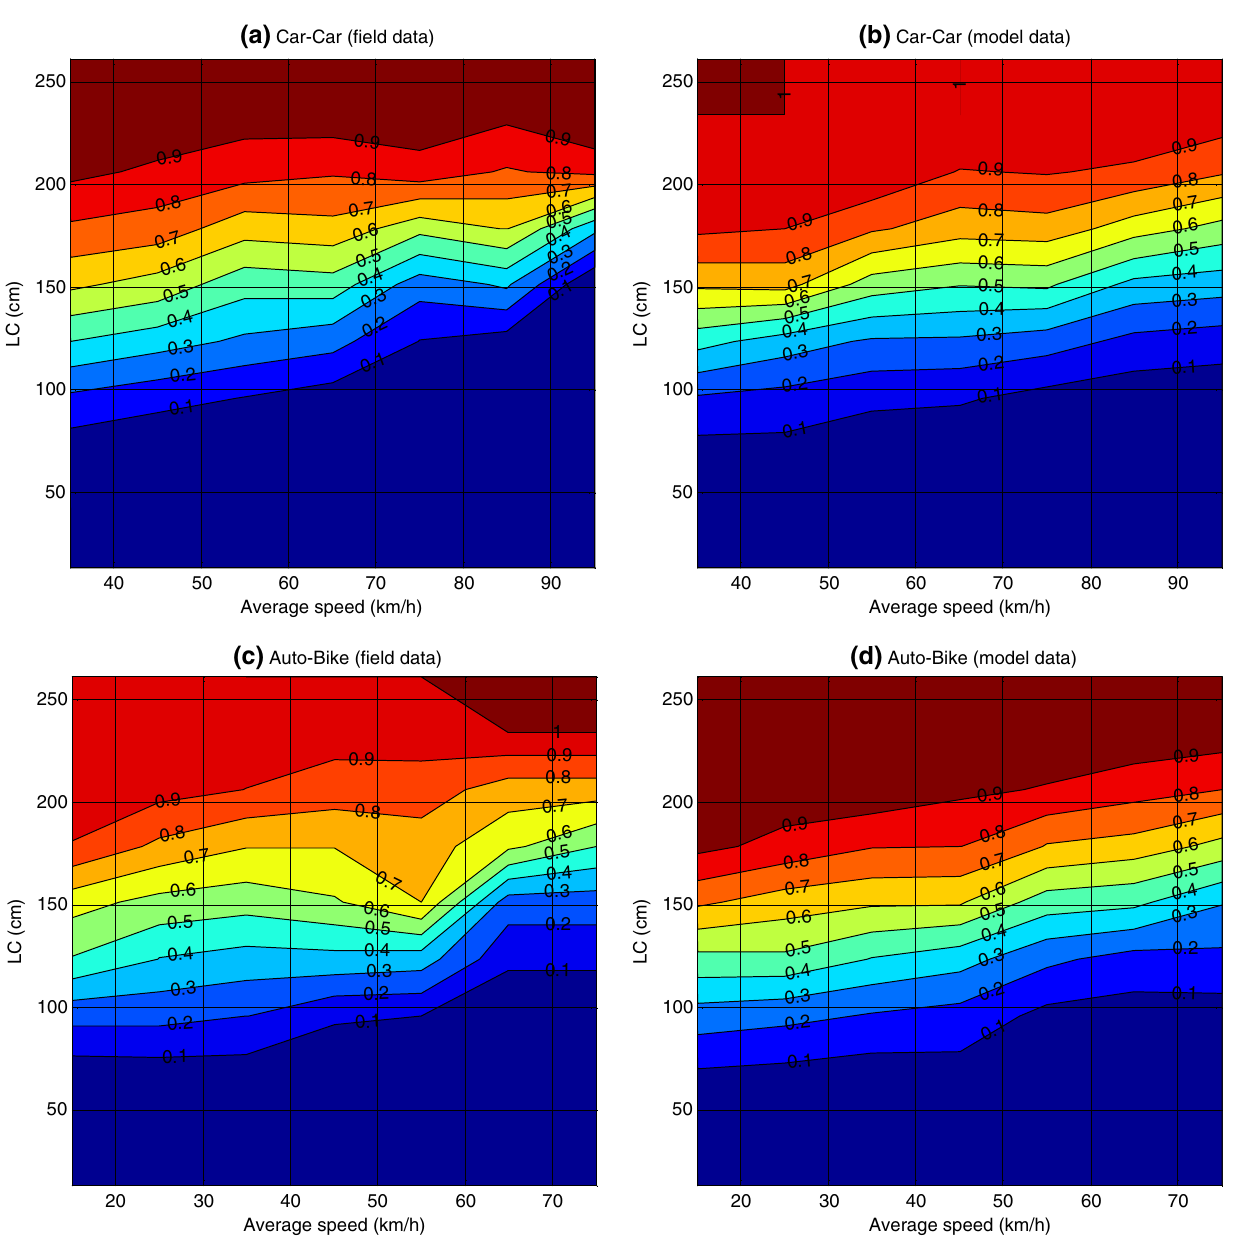
Fig. 13 Frequency plots for field data car–car ( a ), modeled data car–car ( b ), field data auto–bike ( c ), and modeled data auto–bike ( d